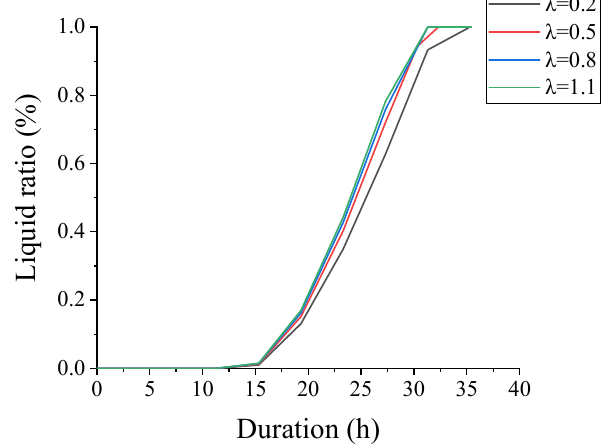
Figure 14. Effect of thermal conductivity on the melting rate of PCMs. Figure 15 shows the influence of different thermal conductivity values on the guar- anteed operation time of the reservoir. As can be seen from Figure 15, the guaranteed operation time of the reservoir is the same with different thermal conductivities. This indicates that the thermal conductivity has no obvious influence on the total heat storage of the reservoir. However, increasing the thermal conductivity value can increase the melting rate of PCMs. In that case, it is feasible to enhance the heat transfer and can be considered in practical application. Under experimental conditions, when λ is 0.5 W/m · K, its thermal conductivity has little difference from that when its value is 0.8 W/m · K and 1.1 W/m · K. Compared with the high thermal conductivity value, it is easier to add graphite and other materials into the PCM to increase the thermal conductivity to 0.5 W/m · K. The heat storage of the system will change little due to the addition of fewer other substances. This can also avoid the possibility of reducing the heat storage capacity of the device when too many high thermal conductivity materials are added to the pure